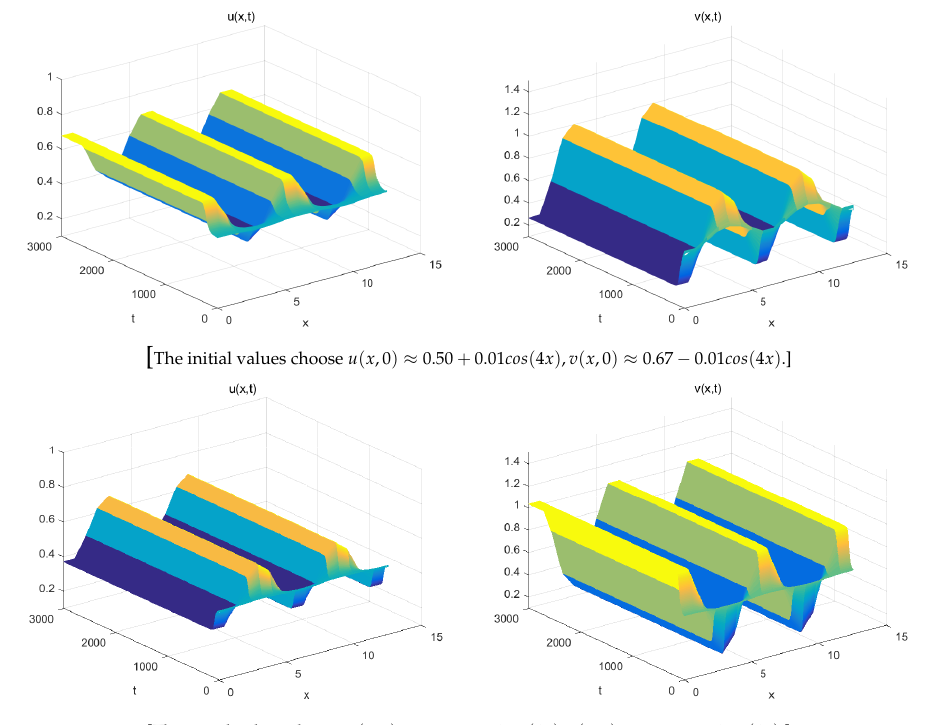
0.01 ) D 2 , there exists a pair of spatially inhomogeneous steady states A ± − ∈